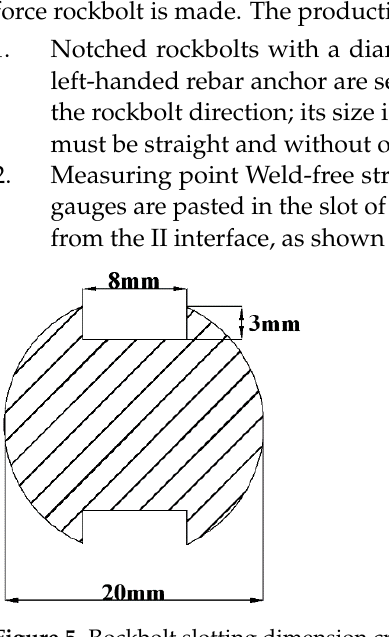
Figure 5. Rockbolt slotting dimension cross-section diagram.